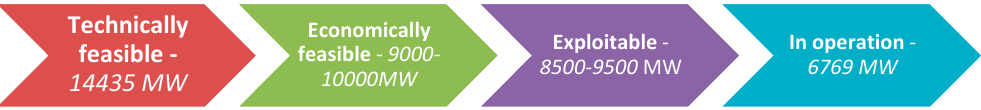
Figure 16. Romanian hydropower potential, Source: Own research based on ANRE data [20].